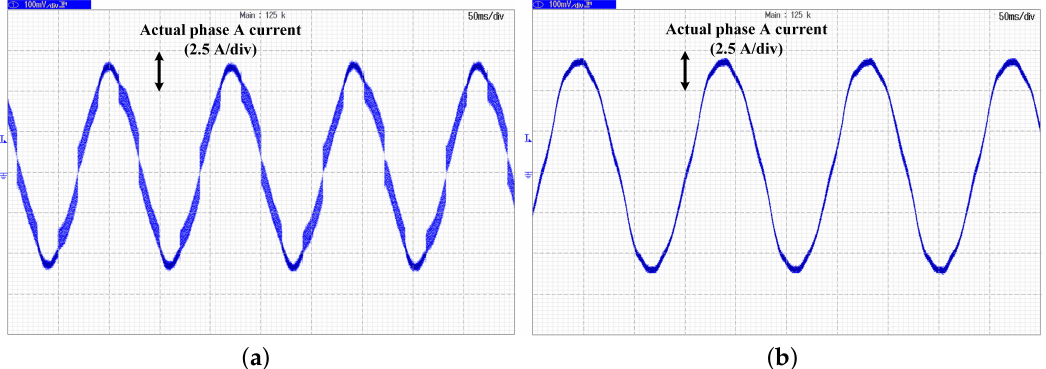
Figure 13. Actual phase currents by using the two methods. ( a ) the single DC-link current sensor method; and ( b ) the novel phase current reconstruction